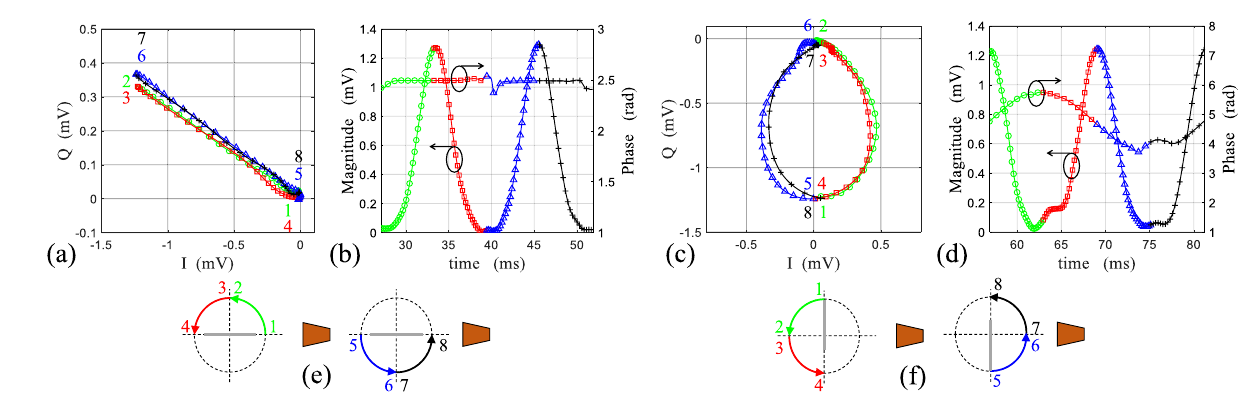
Figure 8. The modulation path during one period of rotation for ( a ) symmetrically, ( c ) non-symmetrically rotating loop. The magnitude and phase variation of the retrieved modulating waveform from measured signal for ( b ) symmetrically, ( d ) non-symmetrically rotating loop during one period of rotation. Each period of rotation is divided to four sections shown in green, red, blue and black color on the modulation path and modulating waveform. The respective orientation of the loop is given at each section for ( e ) symmetrical, ( f ) non-symmetrical rotation.